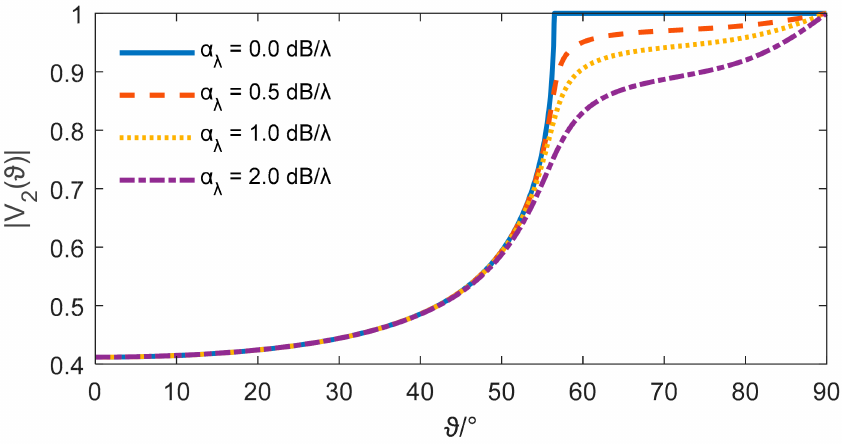
Figure 4. Curves of plane wave reflection coefficients versus angle of incidence for different